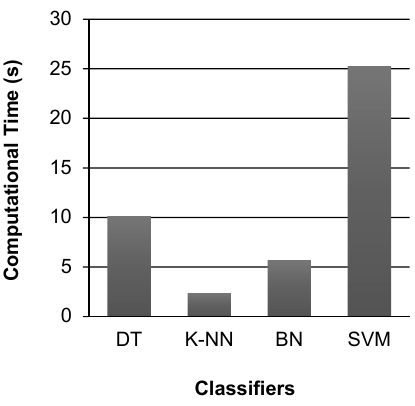
Figure 6. Computational time taken by different classifiers for activity classification.